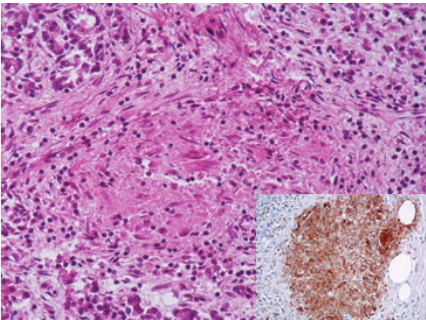
Figure 2: Epithelioid and giant cell granuloma. Haematoxylin and eosin, × 200. Inset: immunohistological detection of CD68 (B).